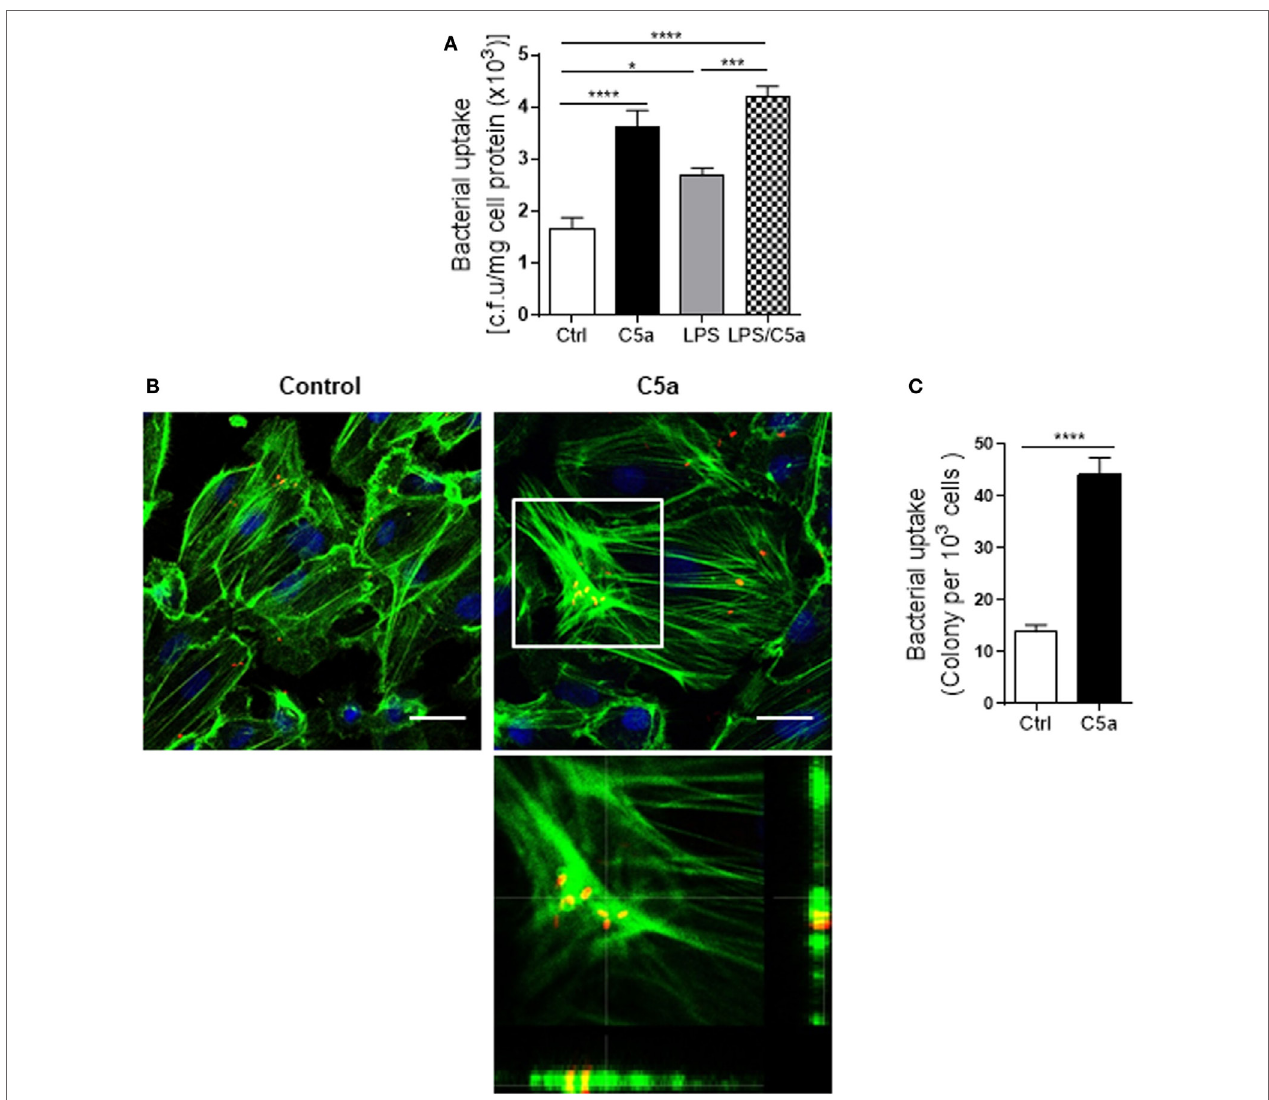
FigUre 2 | Effect of C5a stimulating renal tubular epithelial cell (RTEC) on bacterial internalization into the RTEC. (a) Bacterial uptake by RTEC, evaluated by bacterial plate count assay. RTEC were pre-treated with C5a (10 nM) and/or LPS (800 ng/mL) for 24 h and subjected to the assay. Data were analyzed by one-way ANOVA with Tukey’s multiple comparisons test ( n = 8 individual wells) and representative of three independent experiments. (B,c) Bacterial uptake by RTEC, evaluated by fluorescence microscopy analysis. RTEC were pre-treated with or without C5a (10 nM) for 24 h and subjected to the assay. (B) Representative fluorescence images of (tri-iodothyronine and tetramethylrhodamine-labeled) bacteria internalization into RTEC. Bacteria (red), F-actin (green), and 4’,6-diamidino- 2-phenylindole (blue) are shown. Scale bars, 25 µm. Lower panel image corresponding to the boxed region in the top-right image shows the cross-sectional views in z stack (bottom and side panel) of RTEC, F-actin, and bacteria, demonstrating J96 within the cytoplasm of RTEC. A representative of three experiments is shown. (c) Quantification of bacteria uptake by RTEC corresponding to the images in (B) . Results were expressed as number of bacteria per 10 3 RTEC. Data were analyzed by unpaired two-tailed Student’s t -test ( n = 15 individual images per group). * P < 0.05, *** P < 0.001, **** P <